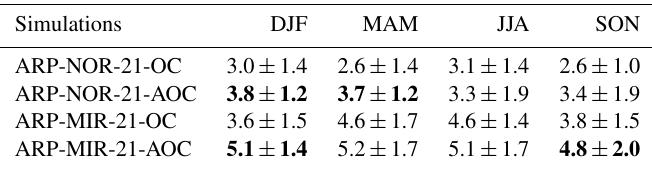
Figure 8. T 2m anomaly for ARPEGE RCP8.5 projection for the late 21st century (reference period: 1981–2010) with atmospheric bias correction (AOC, left), uncorrected atmosphere (OC, center) and difference (right). Anomalies for winter (JJA) are displayed at the top of the subfigures and for summer (DJF) at the bottom. Results for projections with bias-corrected SSCs from NorESM1-M (respectively MIROC-ESM) are shown in panel (a) (respectively b ). Gray contour lines show where differences in anomaly are > 25% with respect to the uncorrected control run. Table 6. Mean seasonal T 2m increase (K) for the Antarctic GIS for the different ARPEGE RCP8.5 projection for the late 21st century with respect to their historical reference simulation. Anomalies in projections with bias-corrected atmosphere significantly different ( p < 0 . 05) from the anomaly in the uncorrected control run level are shown in